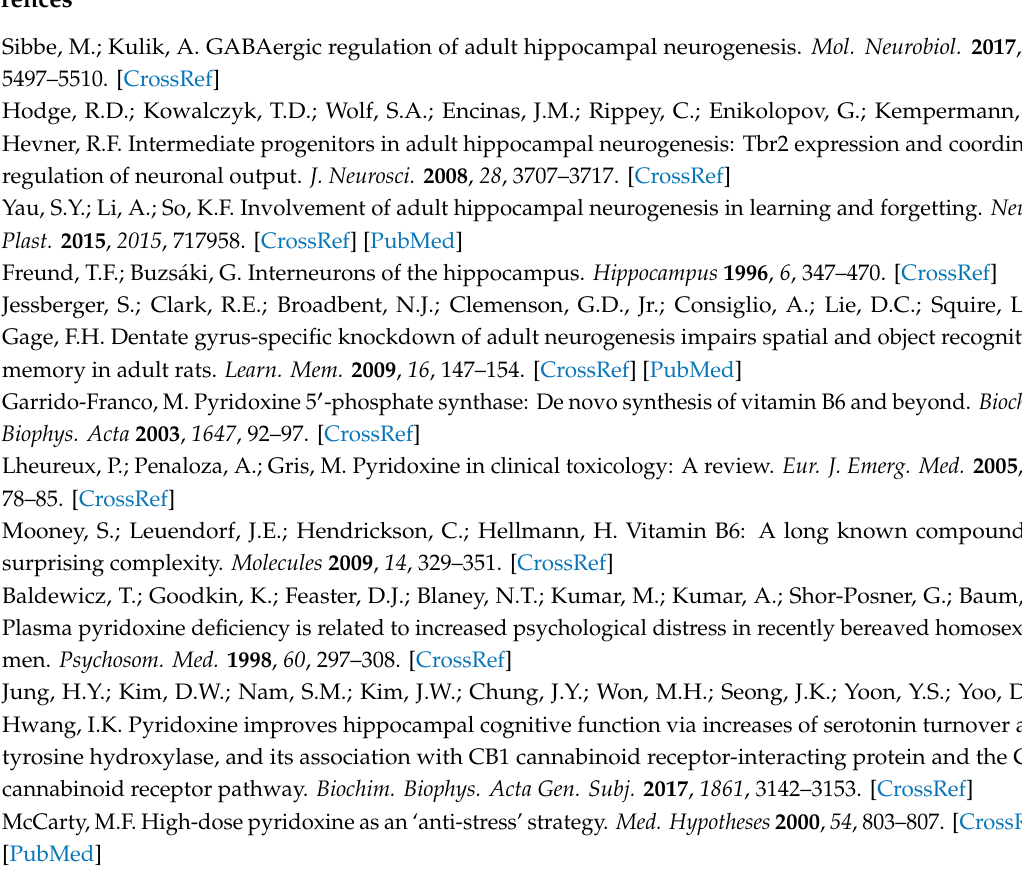
Figure S1: Pyridoxine deficiency has no e ff ects on total exploratory activity in control and Pyr-def mice; data were analyzed with two-way ANOVA followed by Bonferroni